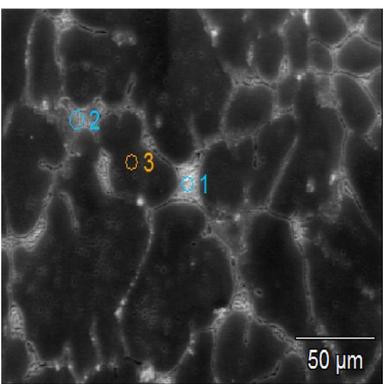
SEM image.